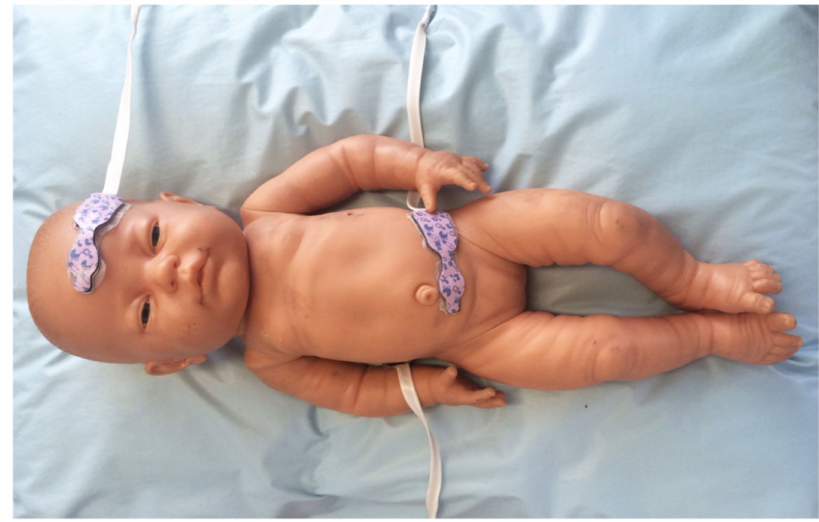
Figure 1. Near-Infrared Spectroscopy (NIRS) technology for assessment of mesenteric perfusion. The study was divided into 4 intervals: Period 0—30 min before the bolus feeding, Period 1—30 min after the bolus feeding, Period 2—30 min before the continuous feeding, and Period 3—30 min after the continuous feeding. For each period, the average SaO 2 , rSO 2 S, and FOES values were